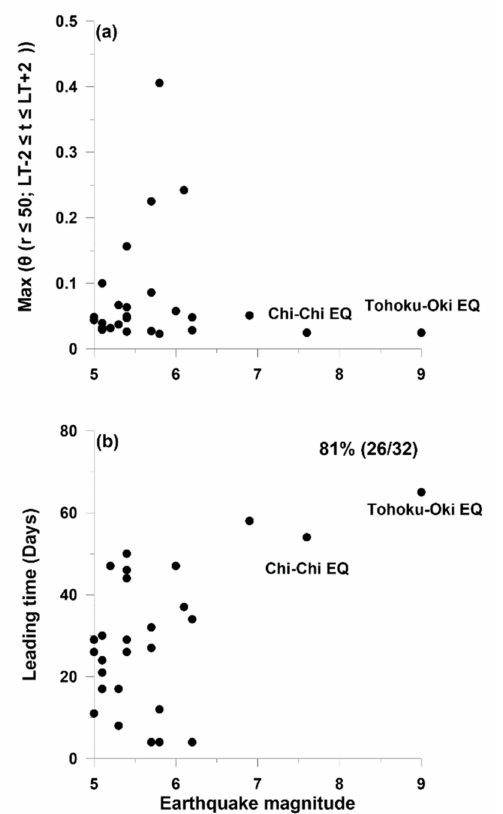
Figure 8. Relationships between the maximum of θ (r, t) , leading time, and earthquake magnitude. Relationships between the maximum of θ (r, t) and earthquake magnitude are shown in ( a ). In contrast, relationships between the leading time and earthquake magnitude are shown in ( b ). The black circles denote the 26 earthquakes detected during the study period. Note that the maximum of θ (r, t) and the leading time associated with the Tohoku-Oki and Chi-Chi earthquakes were computed using di ff erent r values (i.e., r (cid:44) 50 km) because the Tohoku-Oki earthquake occurred far away from the land and due to the relatively-low density GPS array surrounding the Chi-Chi earthquake in